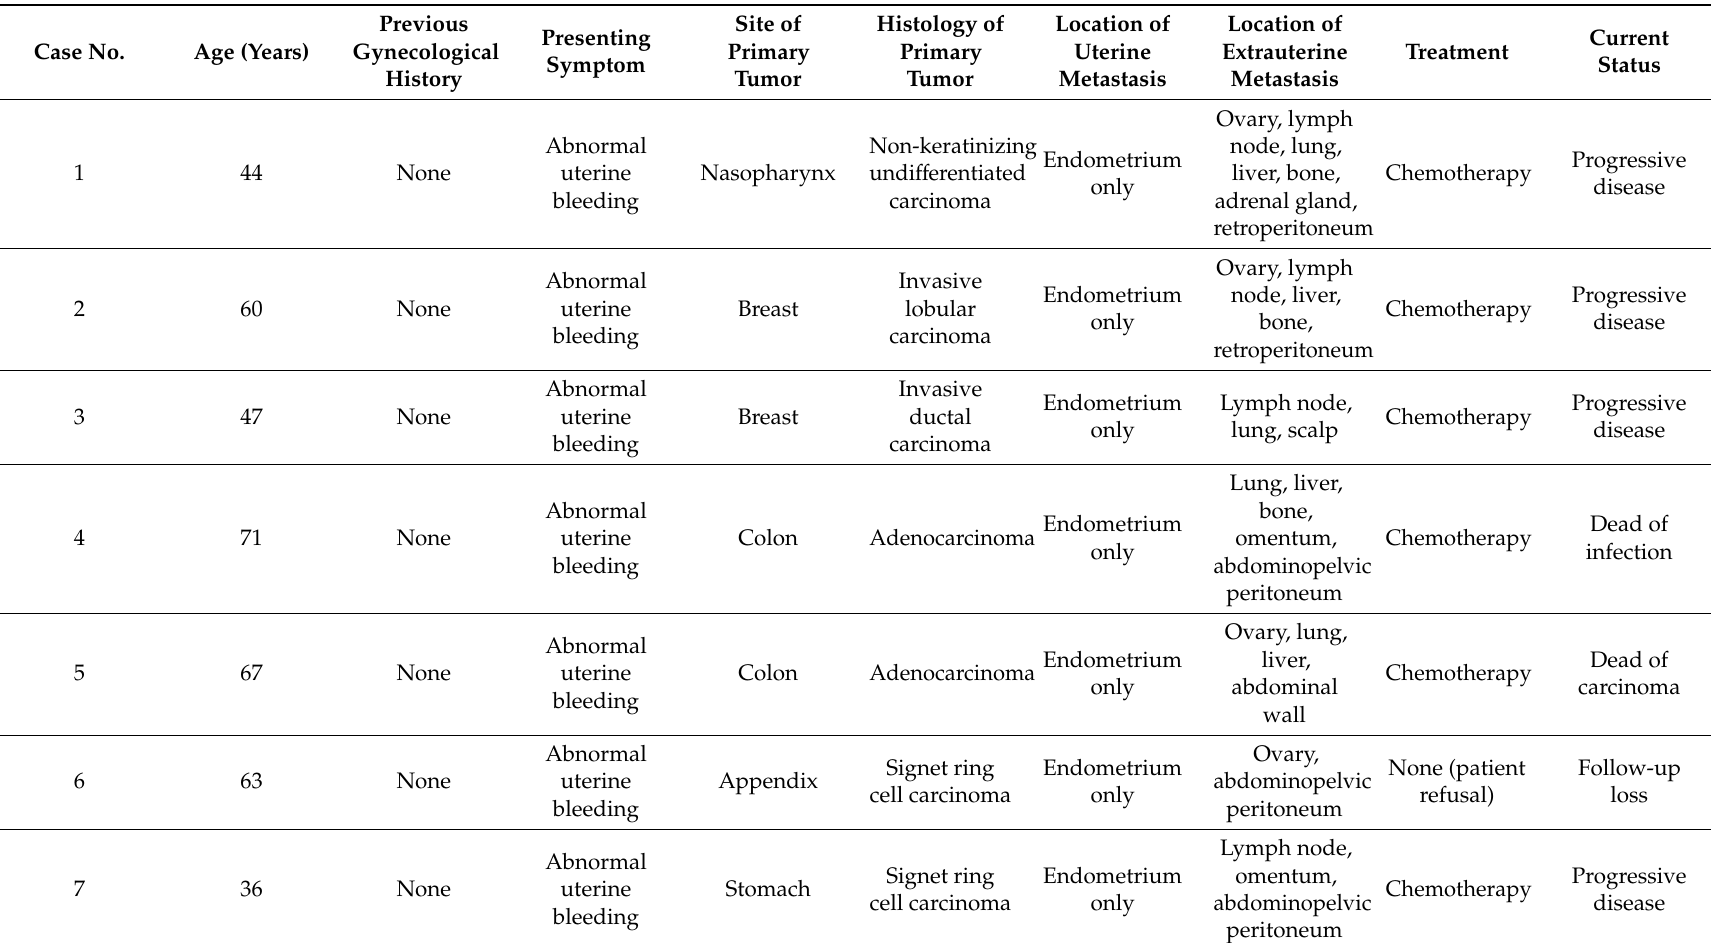
Table 1. Clinical characteristics of the